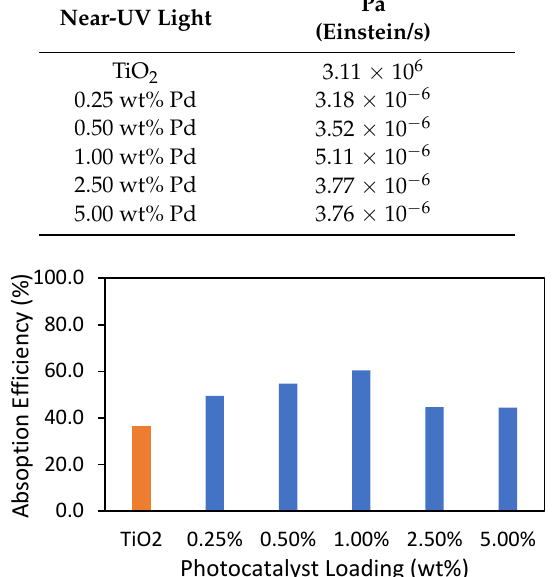
Figure 5. Absorption efficiency on TiO 2 photocatalysts at different metal loadings under near-UV light.